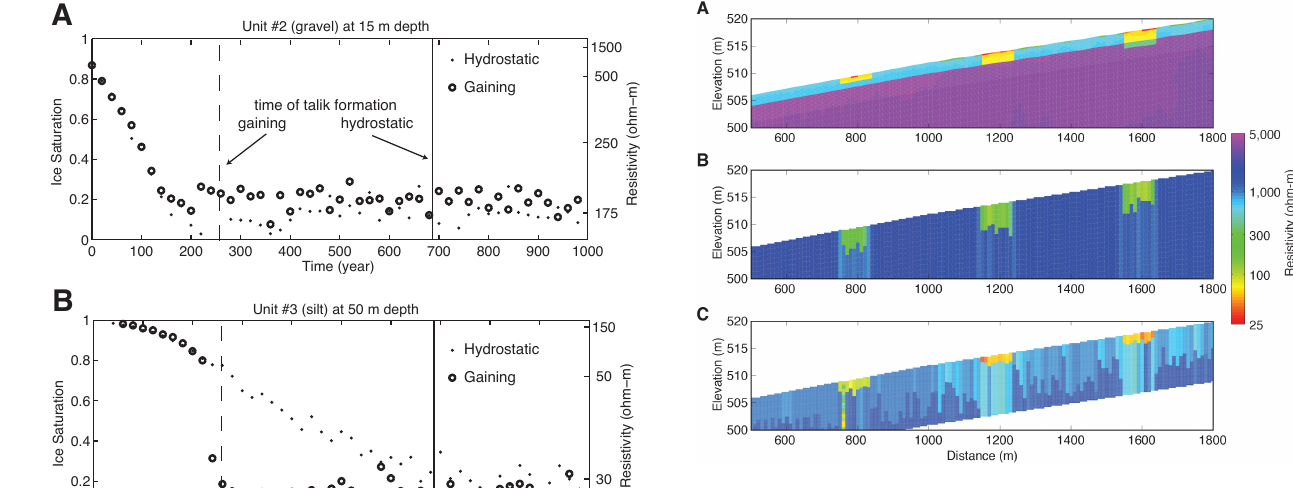
Figure 10. Comparison of airborne and ground-based measure- ments for recovering shallow thaw features. (a) True shallow re- sistivity structure extracted from the hydrostatic 6m deep lake sce- nario at a simulation time of 1000 years, shown outside of the lake extent (distance > 500m). Three shallow low-resistivity channels with thicknesses of 1, 2, and 3m were added to the resistivity model to provide added contrast. McMC-derived results using simulated AEM data (b) and ground-based electromagnetic data (c) illustrate the capability of these systems to image shallow